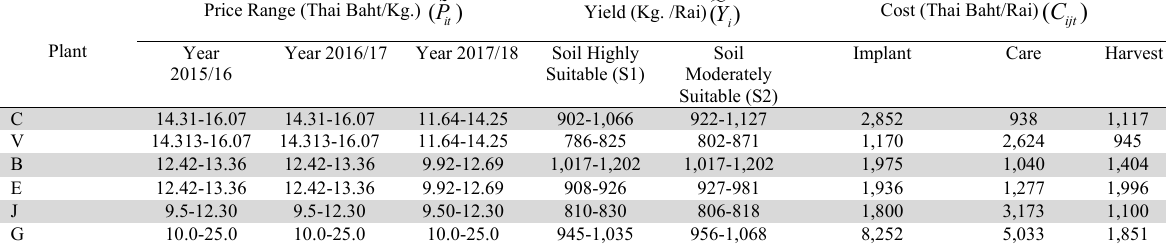
Sales price, quantity of the output, and production costs.